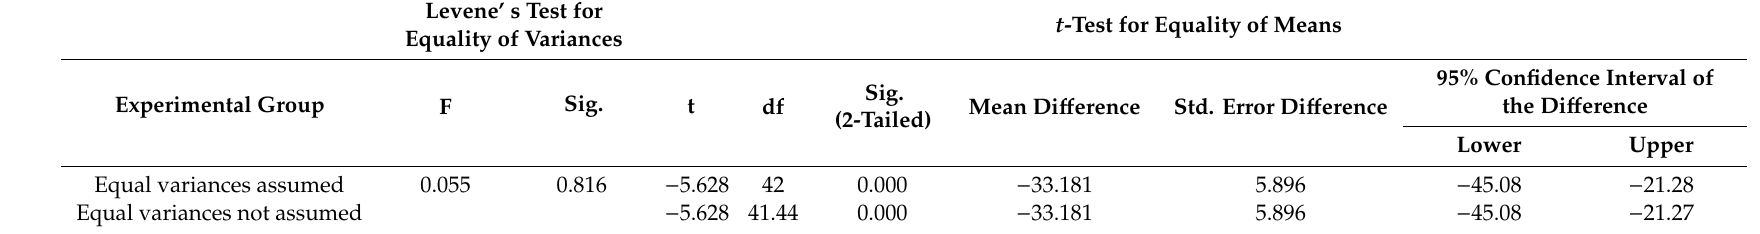
Table 6. Independent sample t-test (pre-test–post-test) experimental group.